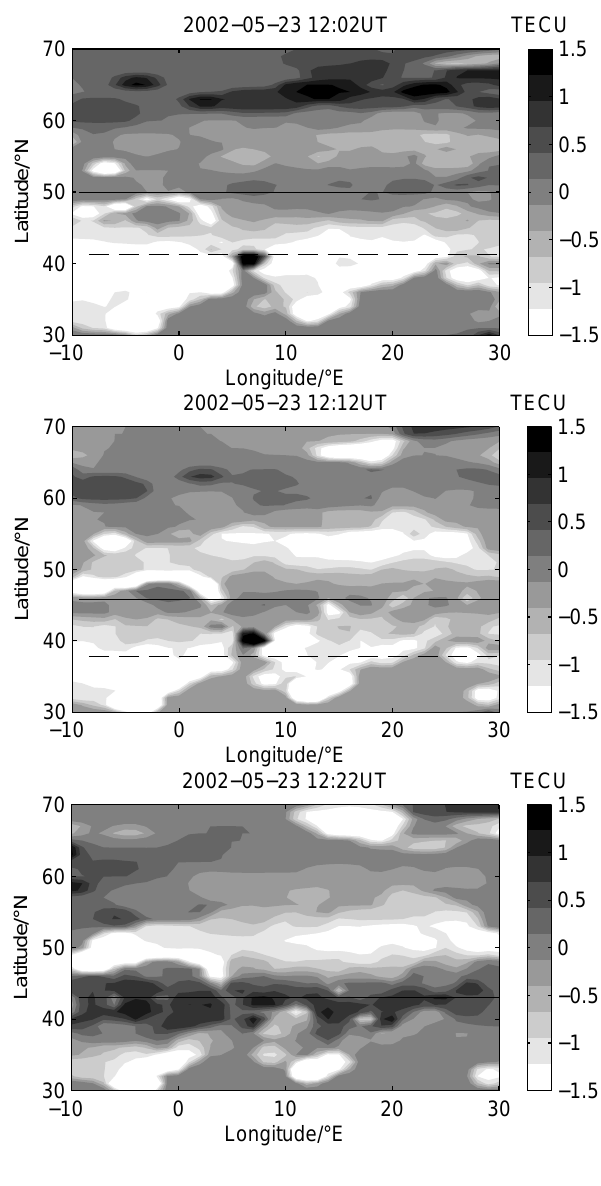
Fig. 2. Perturbation TEC maps on 23 May 2002 12:02–12:22UT. Wave crests/minima are marked with solid/dashed lines, respec-